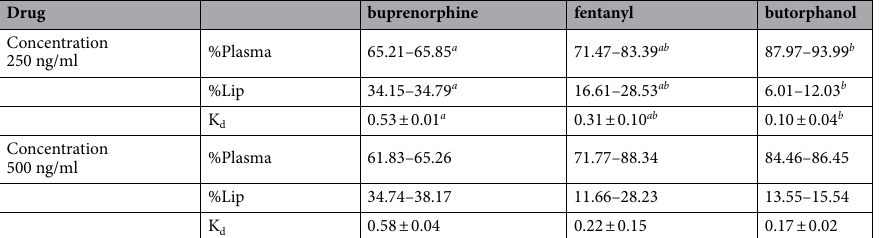
Drug buprenorphine fentanyl